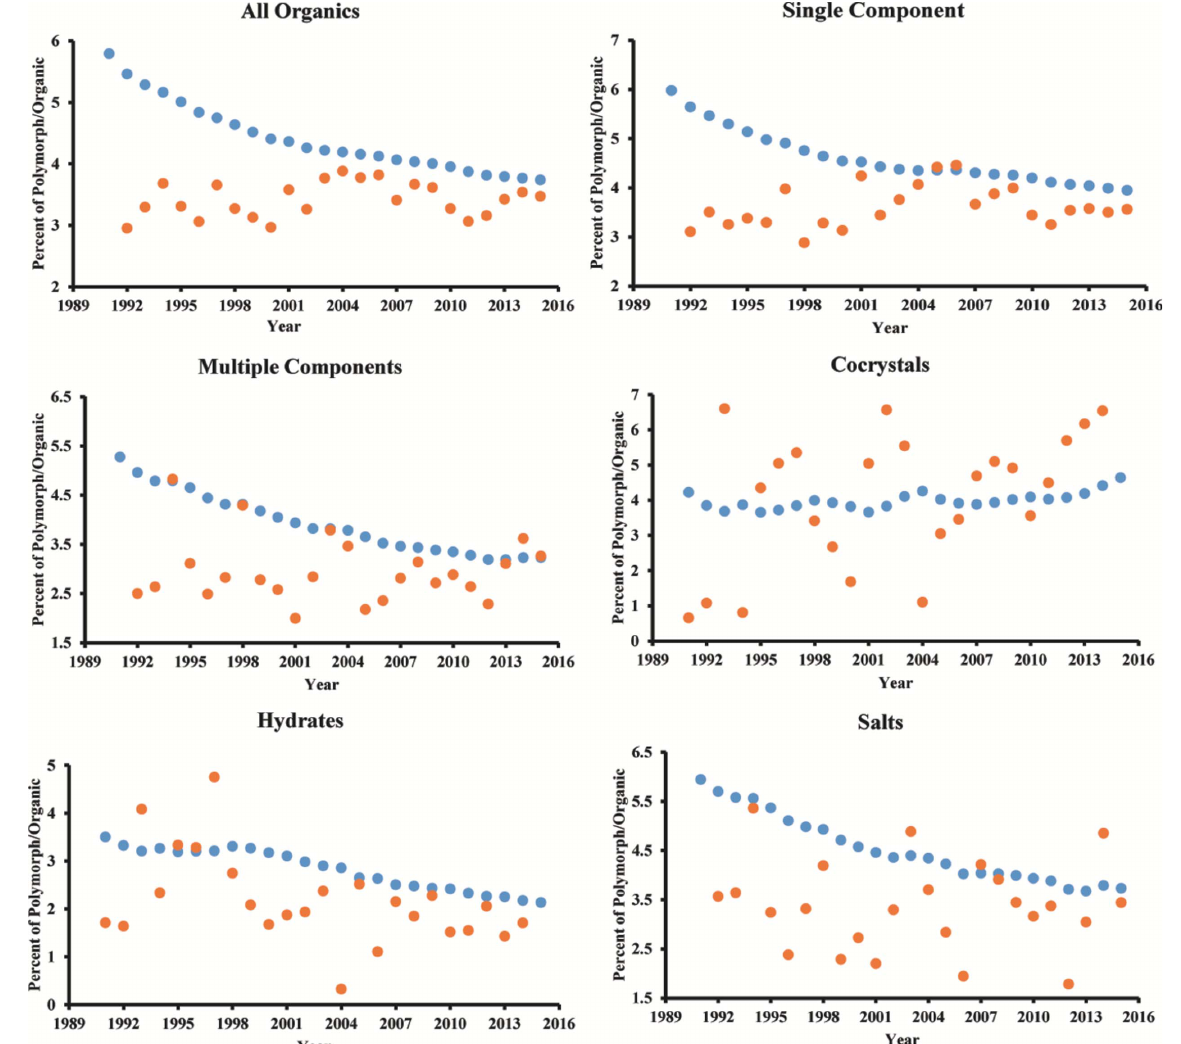
Figure 3 The percentage of polymorphs among all organic compounds in the CSD according to year for specific crystal types. Blue markers refer to the total number of polymorph entries/the total number of organic entries up until that time. Orange markers refer to the number of polymorph entries/the number of organic entries for that year